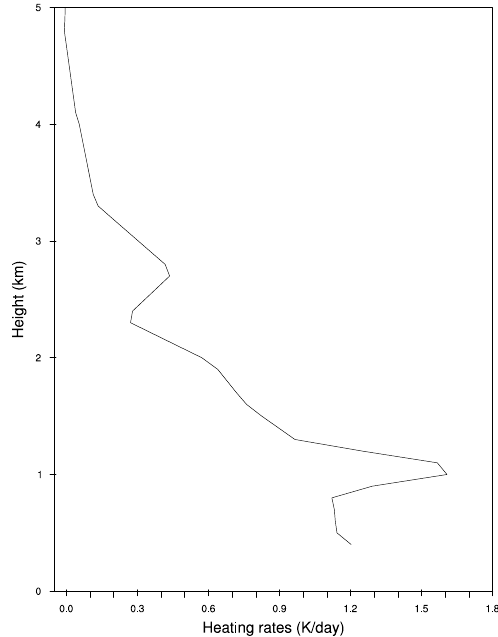
Fig. 8. Dust-induced perturbations of the clear-sky solar heating rates [Kday − 1 ] in atmosphere over the AERONET Solar Village site at 10:00UTC averaged over the simulation period of 7–20 Jan- uary